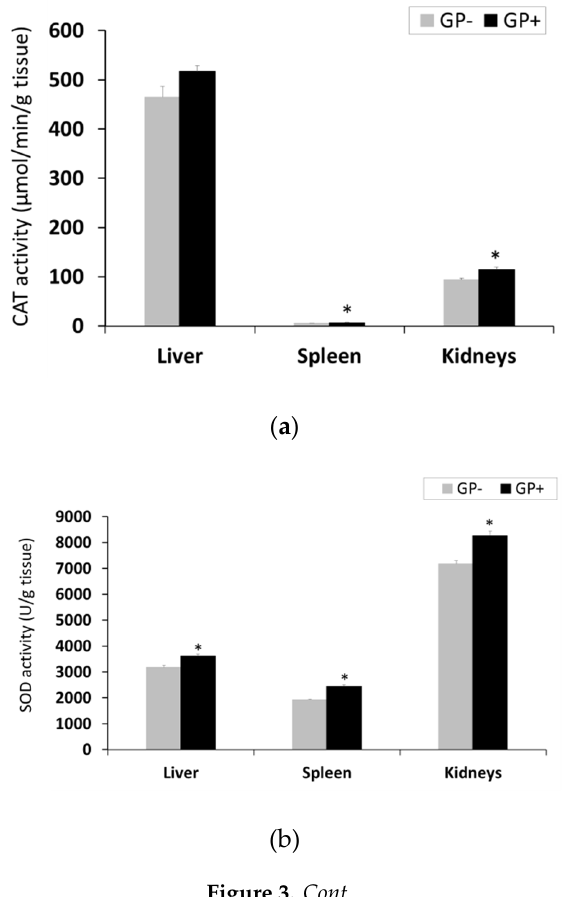
Figure 2. Total antioxidant status (μmol/g tissue) as determined by the total antioxidant status (TAS) assay, in the liver, spleen and kidneys samples (n = 10); * = statistically significant when GP− was compared with GP+.